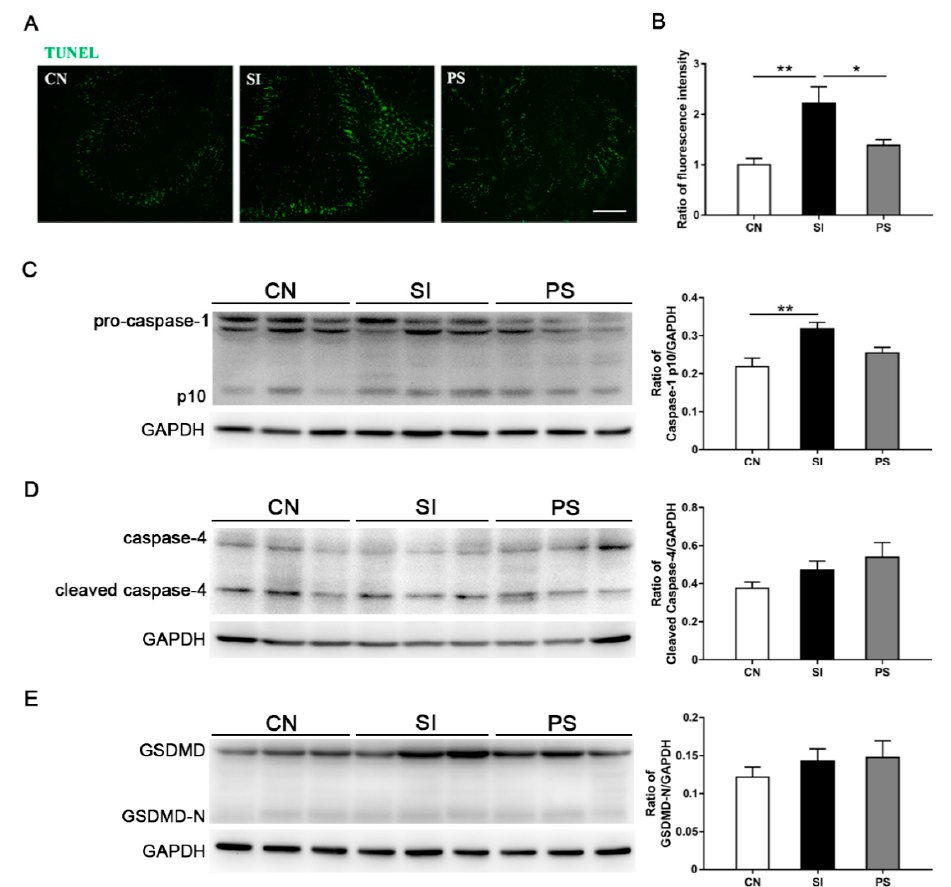
Figure 6. Cell death analysis of the ileum from S . Infantis-infected pigs. ( A ) Terminal deoxynucleotidyl transferase dUTP nick end labeling (TUNEL) analysis in the ileum. Scale bar, 100 µ m. ( B ) Quantification of TUNEL fluorescent labeling. Representative Western blot results for caspase-1 ( C ), caspase-4 ( D ), and gasdermin-D (GSDMD) ( E ) in ileal tissues. Each band represents a single pig. Data are presented as the mean ± SEM ( n = 8 per group). * p < 0.05; ** p < 0.01; *** p < 0.001.